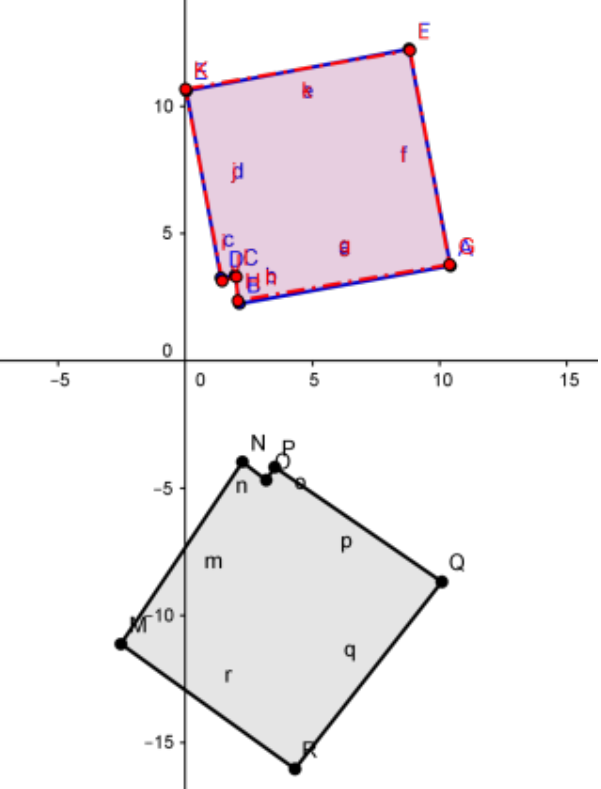
Figure 8: Model calibrated and reconstructed based on the least square adjustment; rangefinder (red dash lines), total station (blue lines) and non-calibrated rangefinder (black